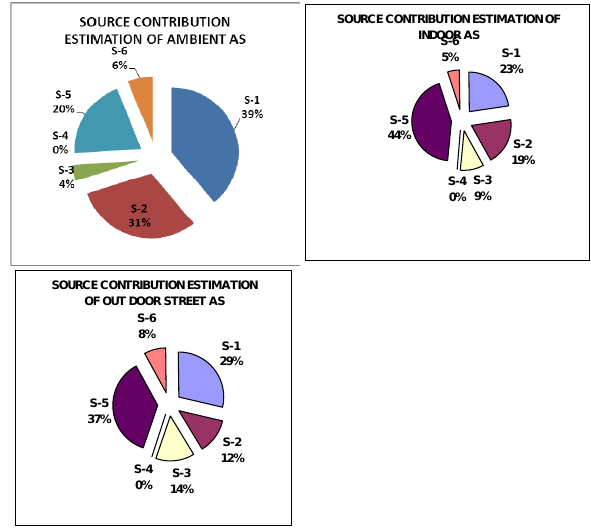
Fig. 4. Relative source contributin estimation of particulate arsenic at selected classifide atmospheric levels at